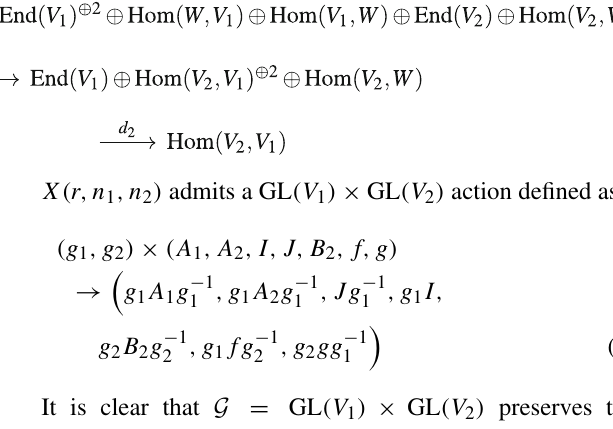
Fig. 3 Enhanced ADHM